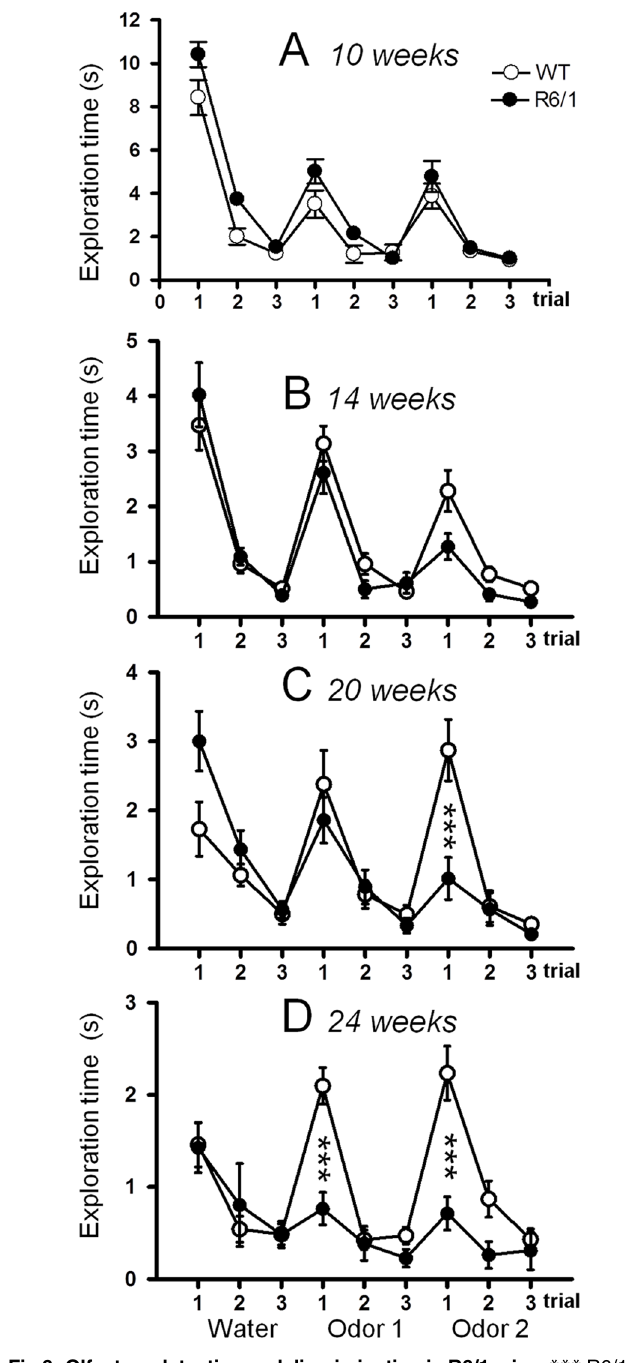
Fig 6. Olfactory detection and discrimination in R6/1 mice. *** R6/1 mice significantly different from age- matched WT littermates at p <